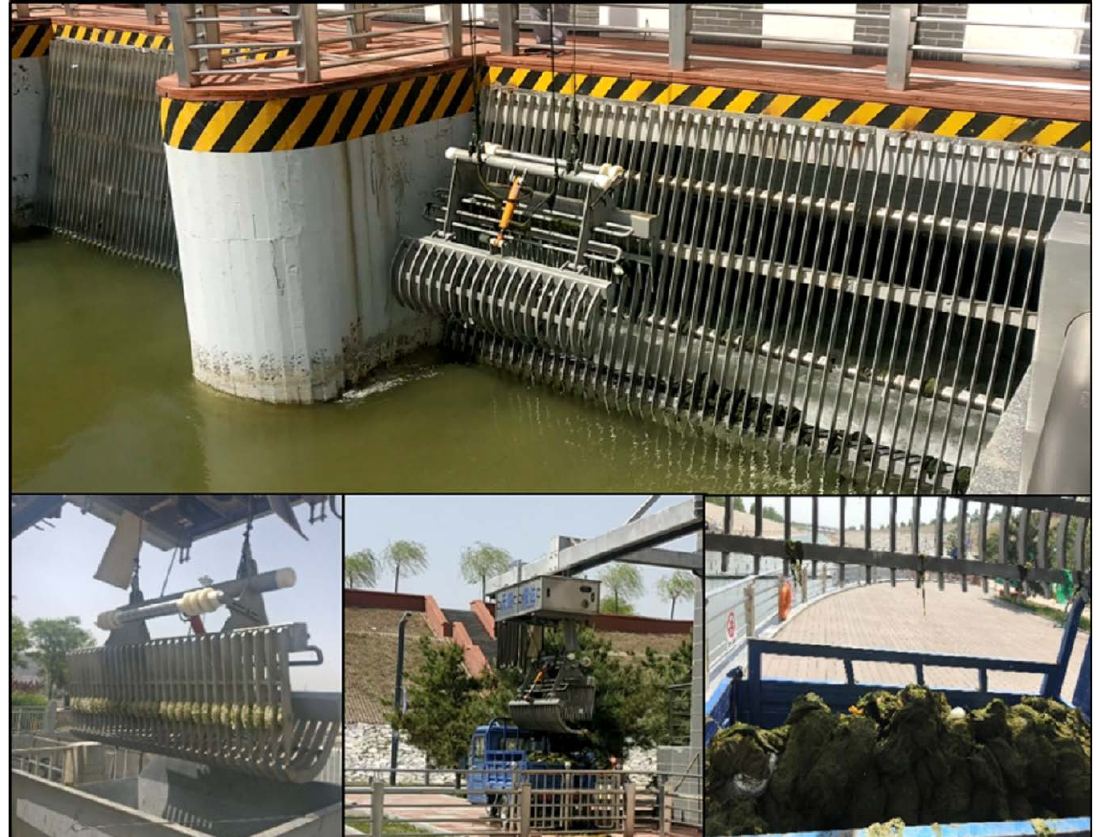
Figure 2. Algae Figure 2. Algae capture.